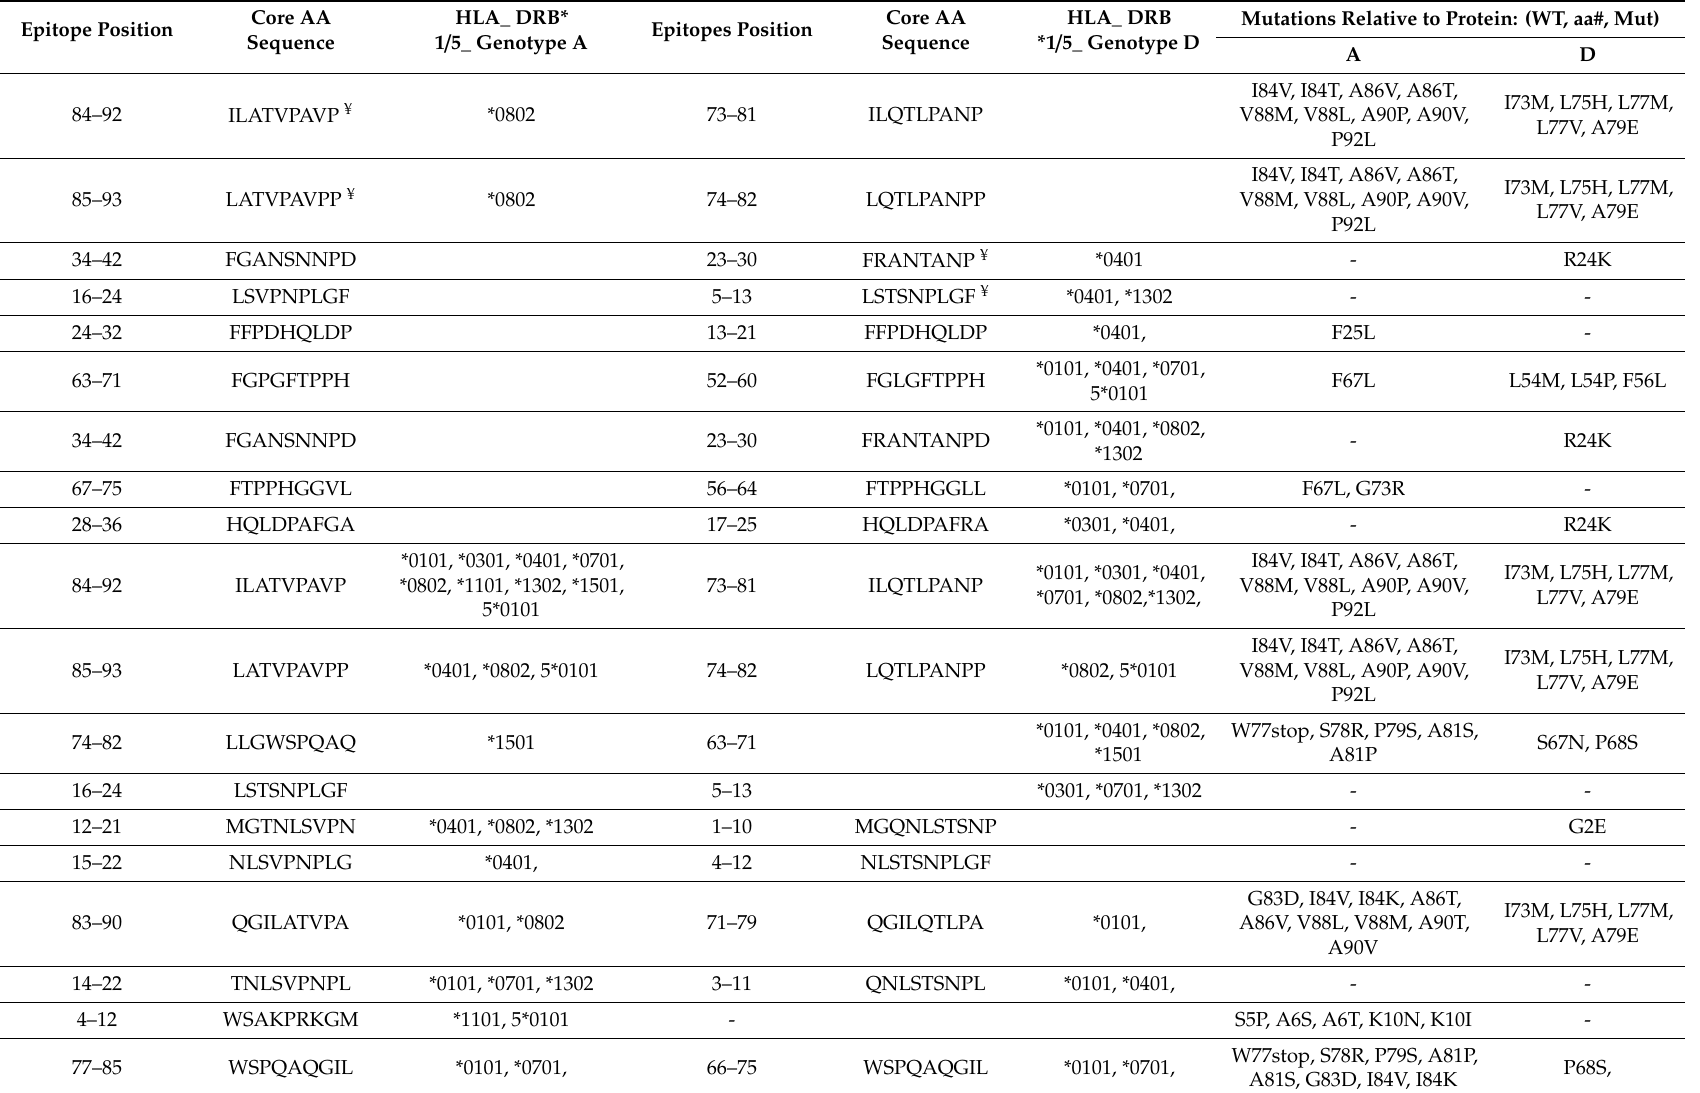
Table 6. Summary of PreS1 epitopes binding to respective alleles, and mutations that exists in the Botswana HBV